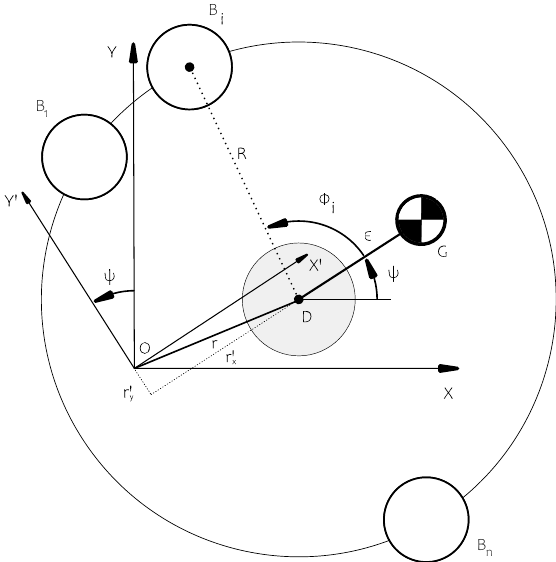
Figure 2. Coordinate definition for the Jeffcott rotor with a concentrically mounted ball